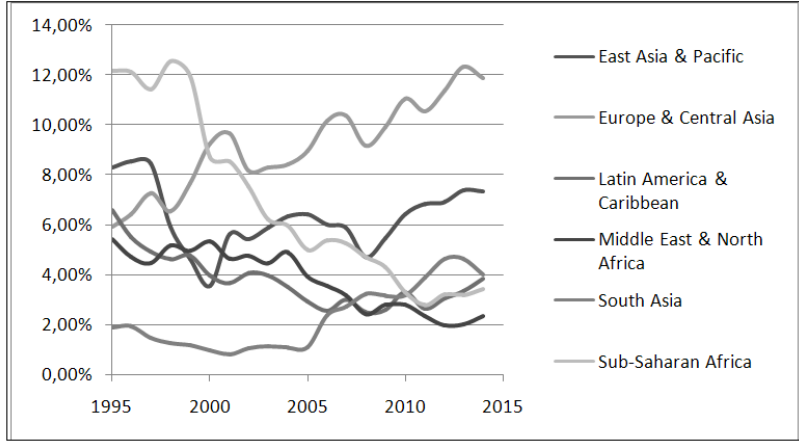
Fig. 7. Trends in ST external debt to GDP region-wise